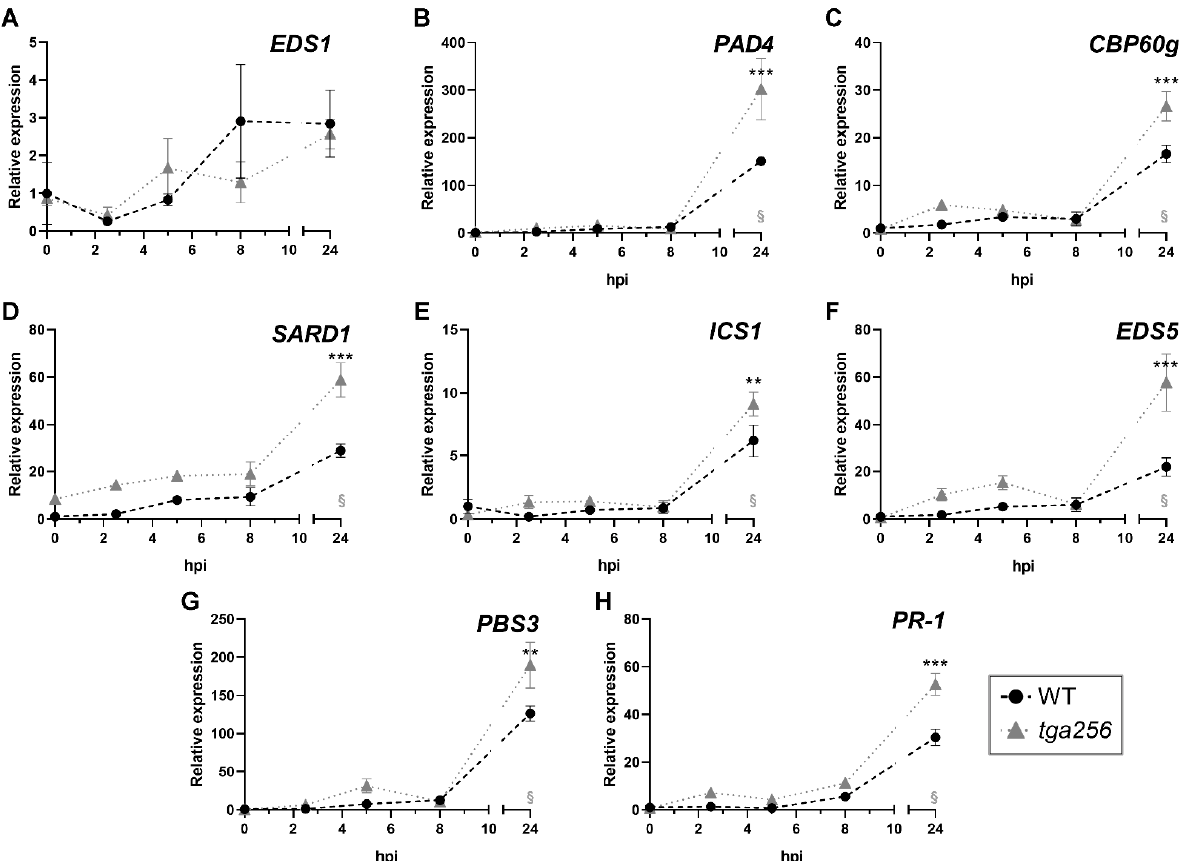
Figure 4. Inoculation with the avirulent P. syringae DC3000/AvrRPM1 induces the upregulation of genes that participate in SA accumulation in the tga256 mutant compared to the WT plants. Four- week-old WT (black circles) and tga256 mutant (gray triangles) plants were syringe-infiltrated with Pst DC3000/AvrRPM1 OD λ 600 = 0.01. Samples were collected 2.5, 5, 8, and 24 h post inoculation (hpi). Non-inoculated plants were used as controls. RNA was extracted and the gene expression of ( A ) EDS1 , ( B ) PAD4 , ( C ) CBP60g , ( D ) SARD1 , ( E ) ICS1 , ( F ) EDS5 , ( G ) PBS3 , and ( H ) PR-1 genes was eval- uated by RT-qPCR. The data represents the mean of the relative gene expression ± SEM from four biological replicates. Asterisks indicate statistical differences according to a 2-way ANOVA and Sidak’s post-test comparing the tga256 mutants with the WT plants at a given time point (**: p < 0.01, ***: p < 0.001). § indicates statistically significant differences in the gene expression at the indicated time compared to the control condition (0) in the WT genotype ( p < 0.05, Dunnet’s post-test).